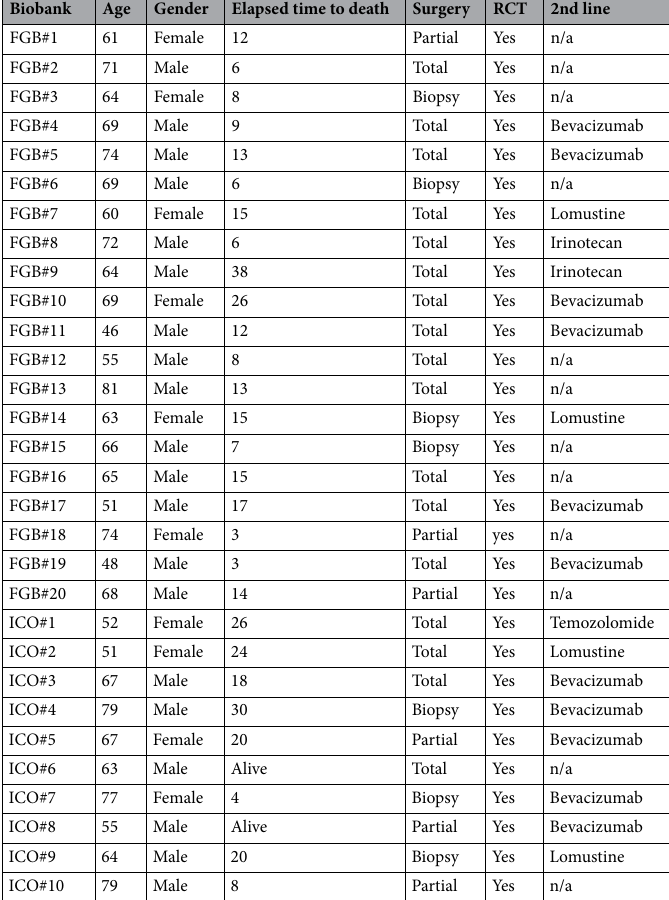
Table 1. Clinical information from GBM patients regarding age at diagnosis, gender, time to death and therapeutical care. Two cohorts were used here (FGB and ICO, as described in the method section). Elapsed time from diagnosis to death is expressed in